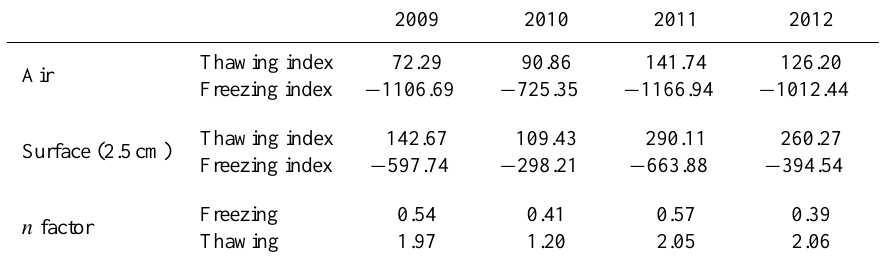
Table 7. Freezing and thawing indexes (0 ◦ Cday) of air and surface, and the resulting freezing and thawing n factors (dimensionless) for the different years of the study period, based on calculated mean daily temperatures.